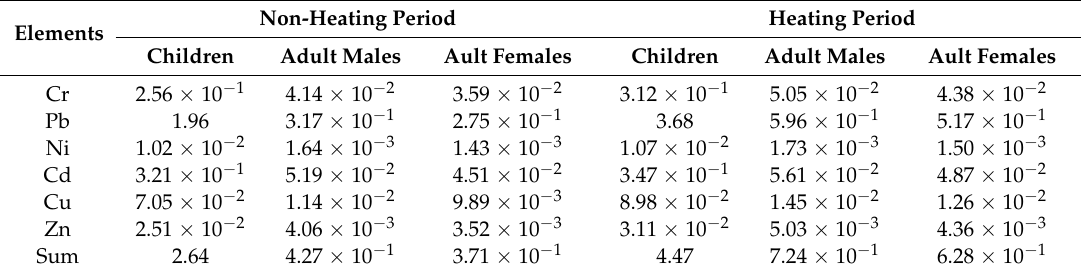
Table 8. The non-carcinogenic risks of heavy metals via inhalation.